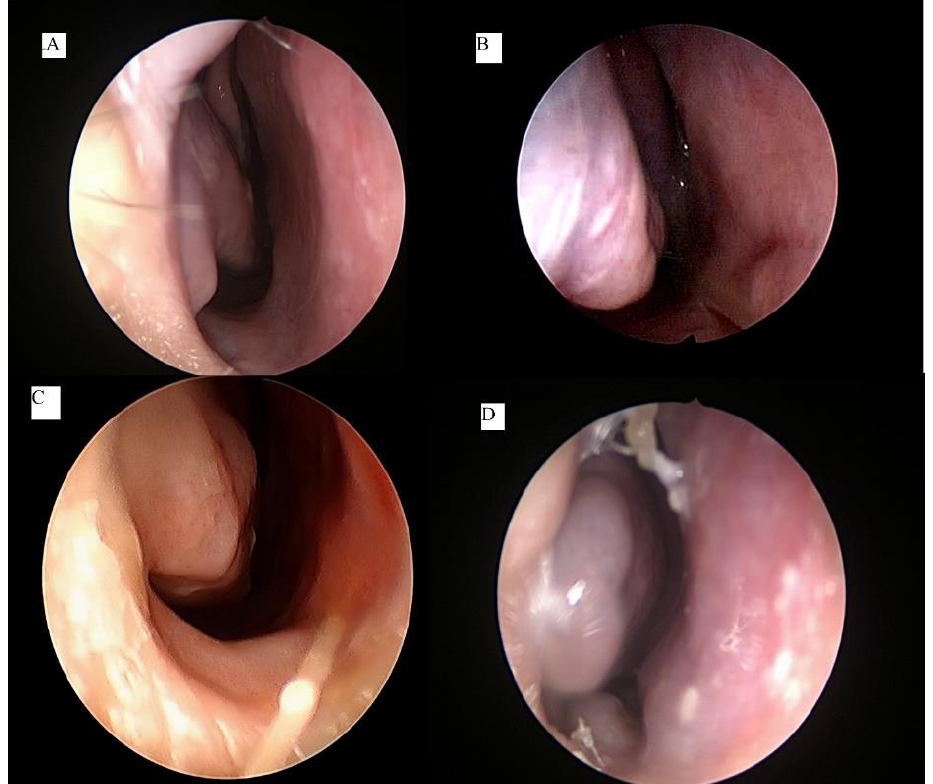
Figure 1. Nasoendoscopic grading system of inferior turbinate hypertrophy; grade 1 is 0–25% of total airway space occupied ( A ), grade 2 is 26–50% occupied ( B ), grade 3 is 51–75% occupied ( C ), and grade 4 is 76–100% occupied ( D ).